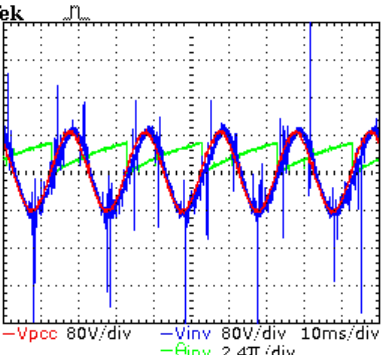
Figure 16. Experiment result of voltage control mode of grid-connected inverter.